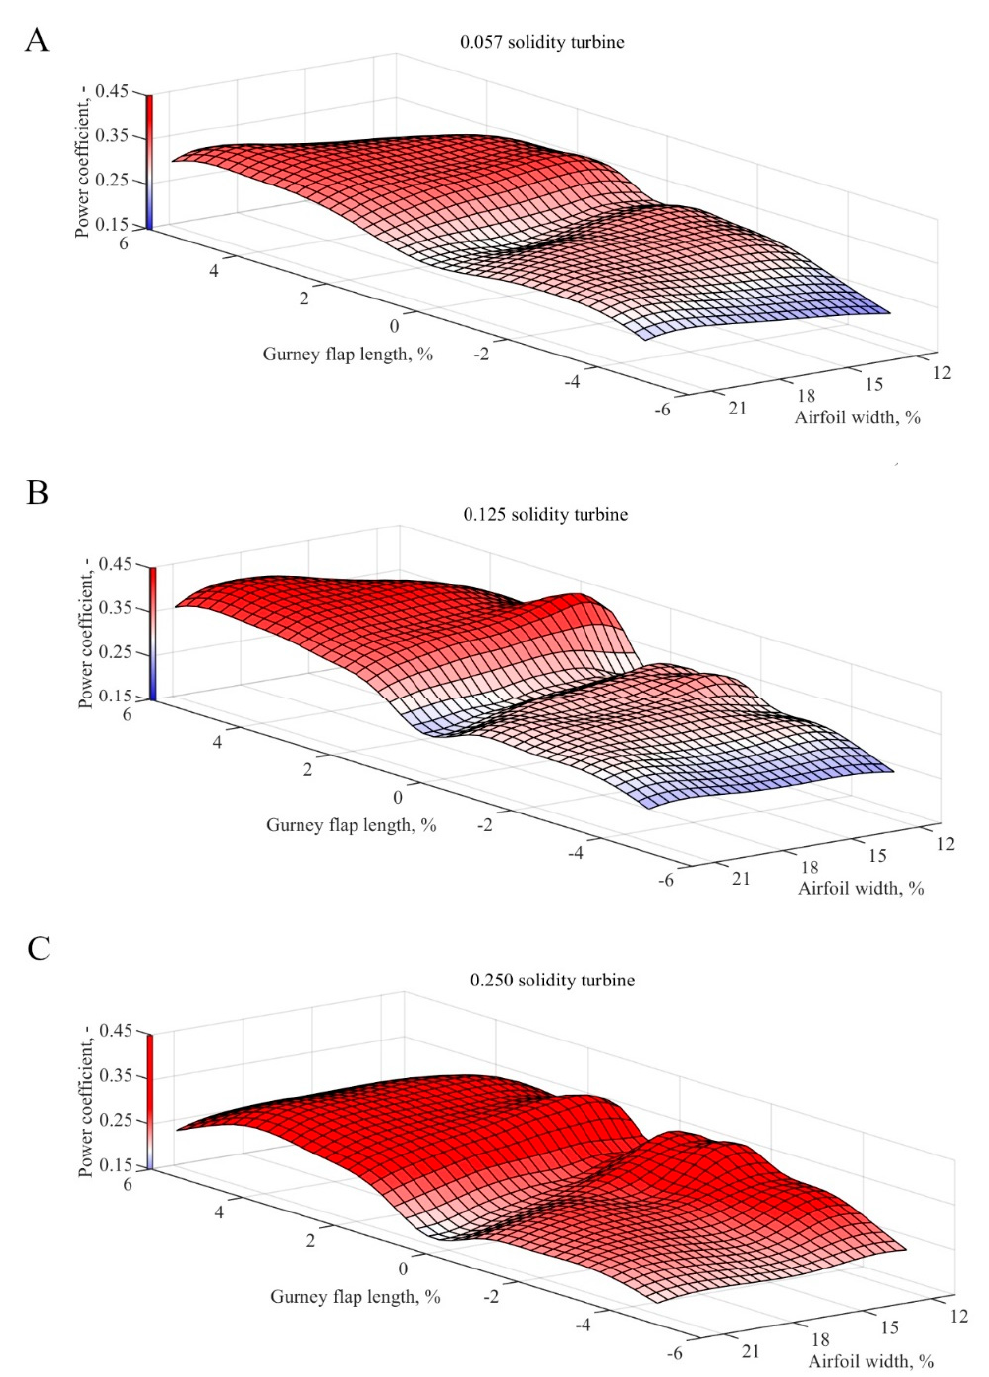
Figure 20. Power coefficient for one-sided Gurney flap using IMQ functions for ( A ) 0.057, ( B ) 0.125, and ( C ) 0.25 equivalent solidity turbines.